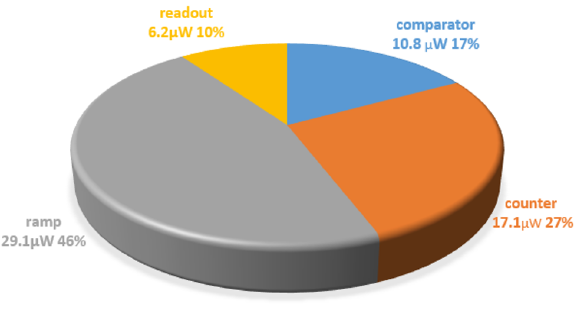
Figure 24. Power breakdown of the SS-ADC in one column.